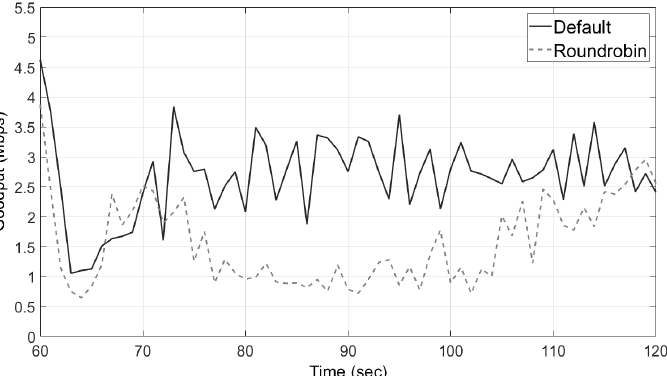
Figure 12. The round-robin scheduler’s problem in a low-quality communication situation.